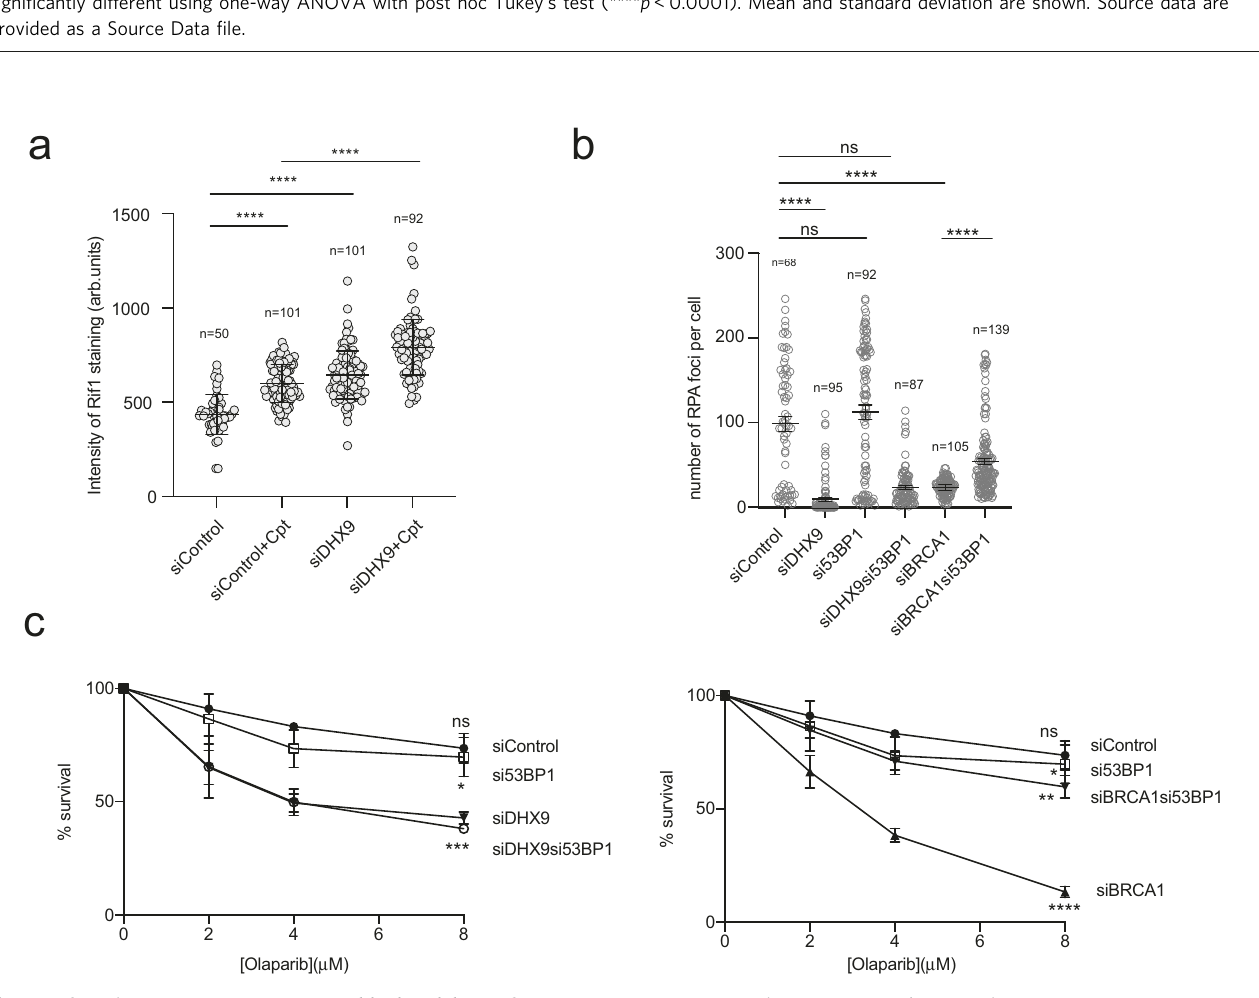
Fig. 8 Defects in DHX9 are not suppressed by knockdown of 53BP1. a DHX9 suppresses the recruitment of RIF1 to chromatin in response to camptothecin-induced DNA damage. The intensity of chromatin-bound RIF1 staining is plotted. Mean and standard deviation are indicated. b Defect in the recruitment of RPA into foci in DHX9 defective cells is only partially restored by knockdown of 53BP1. A number of RPA foci is plotted for cells knocked down for the indicated genes using siRNA. Quanti fi cation of n cells (as indicated) from three pooled biologically independent experiments were performed in ( a ) and ( b ). c Knockdown of 53BP1 does not restore Olaparib resistance to DHX9 depleted cells in a clonogenic survival assay (left panel) but does restore Olaparib resistance to BRCA1 defective cells (right panel). The data sets for DHX9 and BRCA1 were performed concurrently, with the same controls, but are depicted separately for presentation purposes. Survival values were quanti fi ed from n = 3 biologically independent experiments. ( a – c ) Statistical analysis performed using one-way ANOVA and multiple comparisons analysed using post hoc Tukey ’ s test in ( a ) and ( b ). (ns not signi fi cant, * p < 0.1, ** p < 0.01, *** p < 0.001, and **** p < 0.0001). Means and error bars indicating one standard deviation are also indicated. Source data are provided as a Source Data fi model for transcription-associated homologous recombination repair (TA-HRR) in which R loops recruit RAD52 and BRCA1 to initiate HR and suppress recruitment of RIF1-53BP1 for NHEJ 33 .